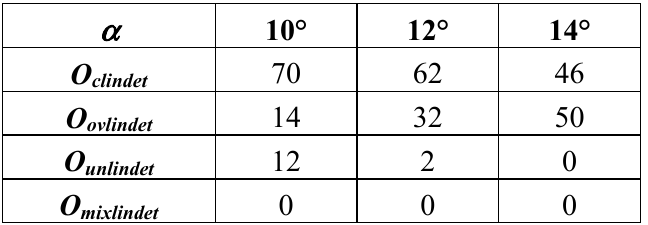
Table 3. Multi-line waved text segmentation test results.